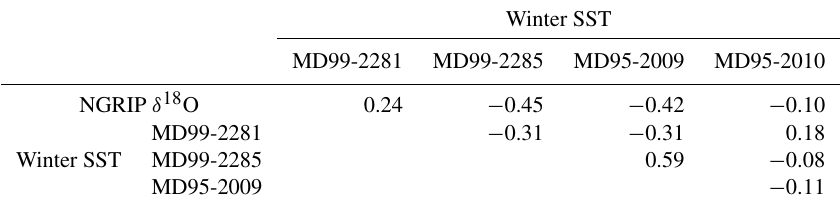
Table 3. Correlation coefficients over the 48–30kacalBP interval between Greenland temperatures (NGRIP δ 18 O; North Greenland Ice Core Project members, 2004; Svensson et al., 2008), North Atlantic (MD99-2281) and Norwegian Sea (MD99-2285, MD95-2009, MD95-2010) winter